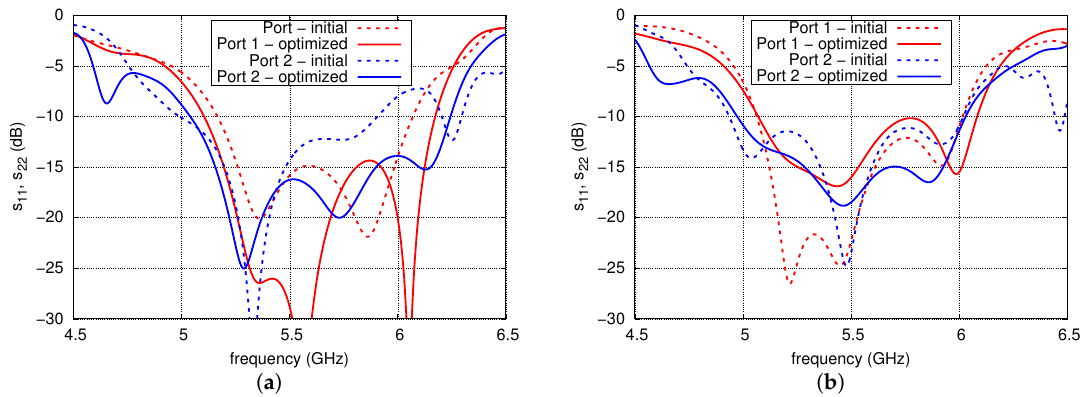
Figure 15. The s 11 and s 22 of initial and optimised array for: ( a ) version 1; ( b ) version 2.